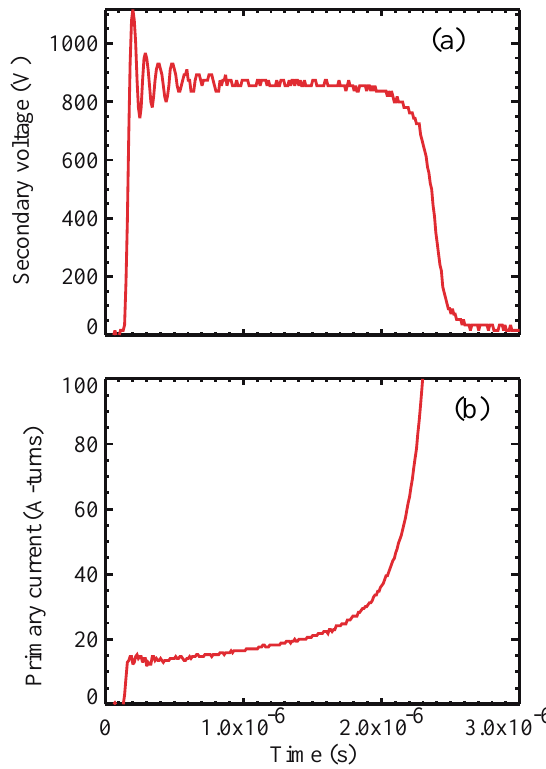
FIG. 3. (Color) Comparison of the (a) secondary voltage and (b) primary drive current for a FINEMET core, 982-3. variations in loss, but with only a few samples of